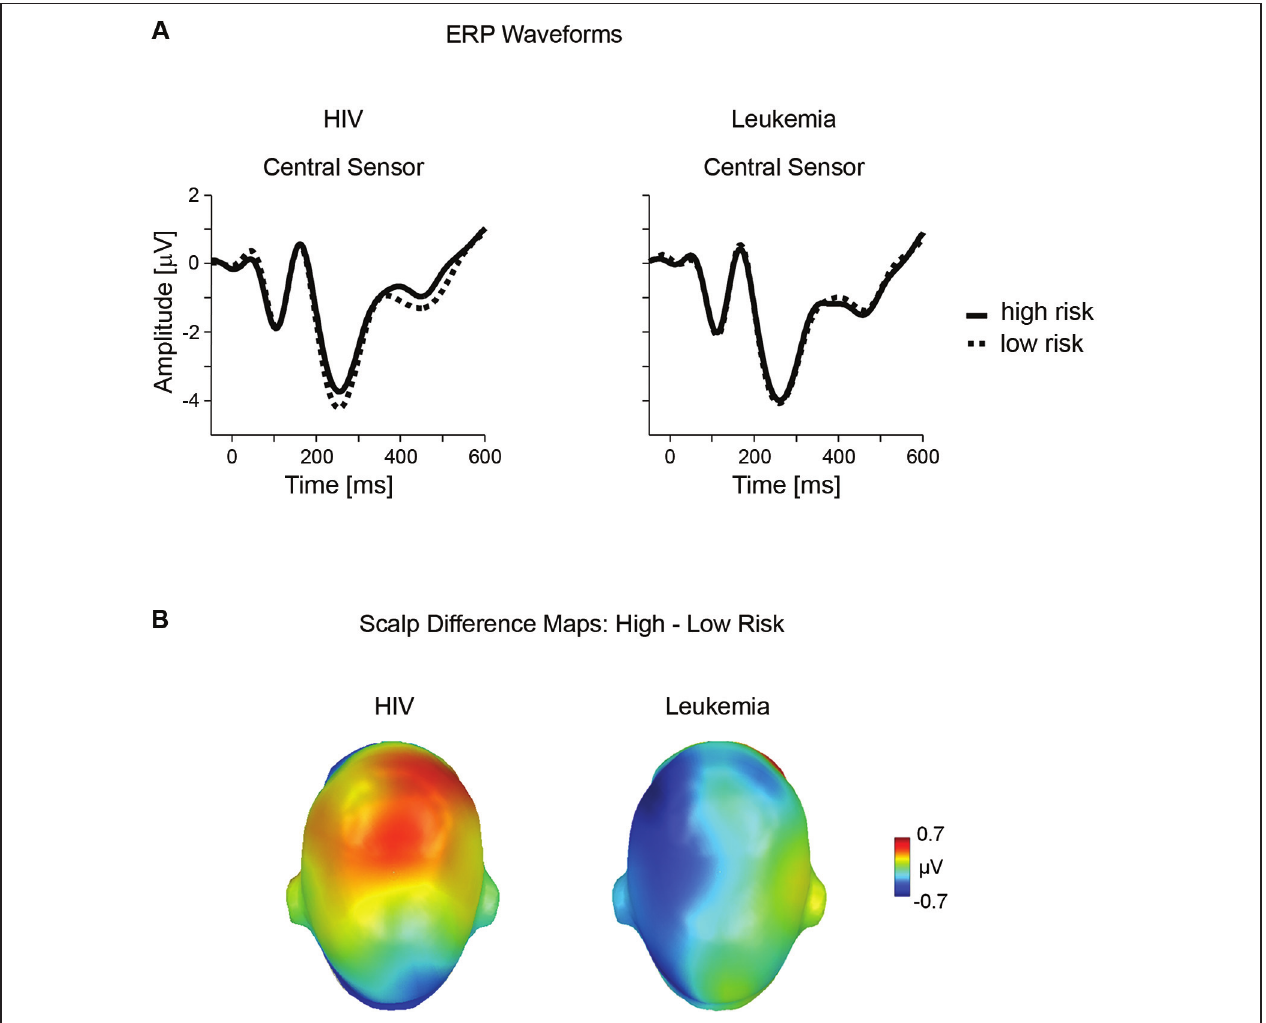
shows the topography of the difference between the high and low risk categories for HIV and leukemia risk averaged across the time window from 390–510